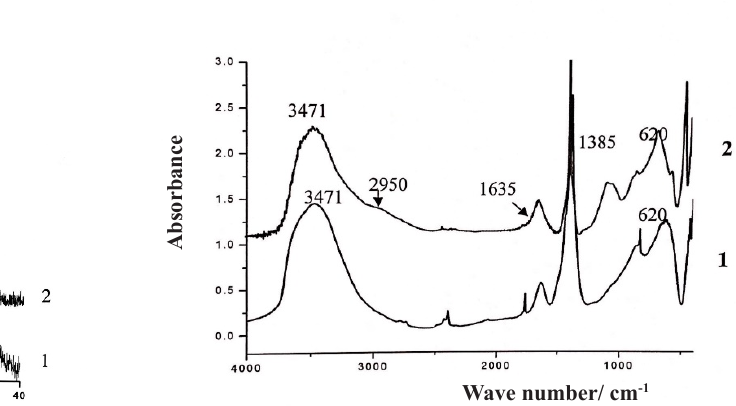
Figure 1.a: Powder XRD patterns of (1) Mg/Al NO 3- LDH (2) Trypsin adsorbed on Mg/ AlNO 3- LDH